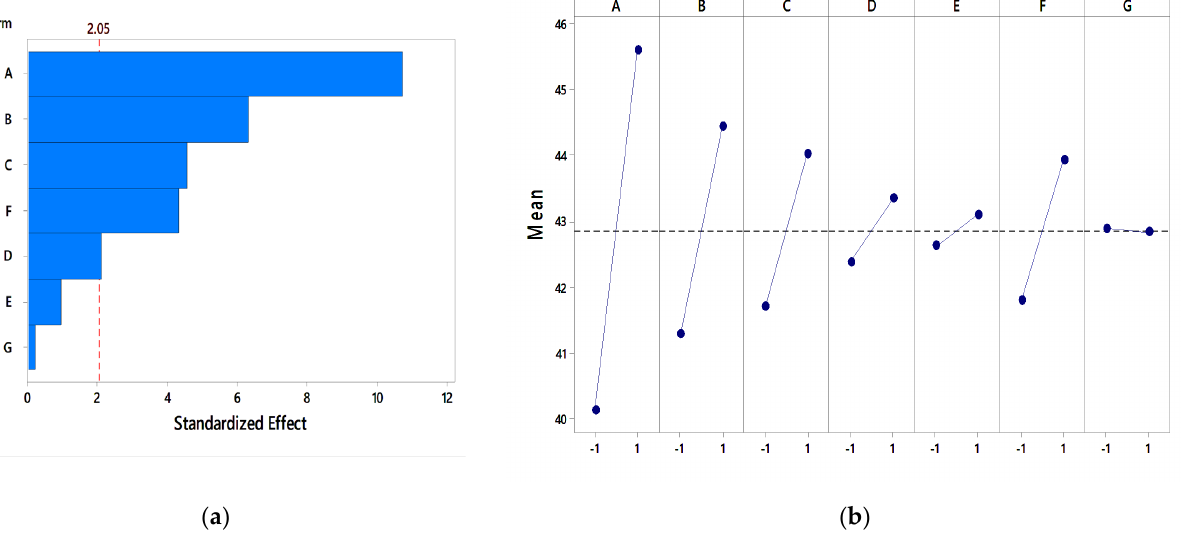
Figure 7. Analysis of the PB for mineral salts ( a ) Pareto chart, ( b ) main effect